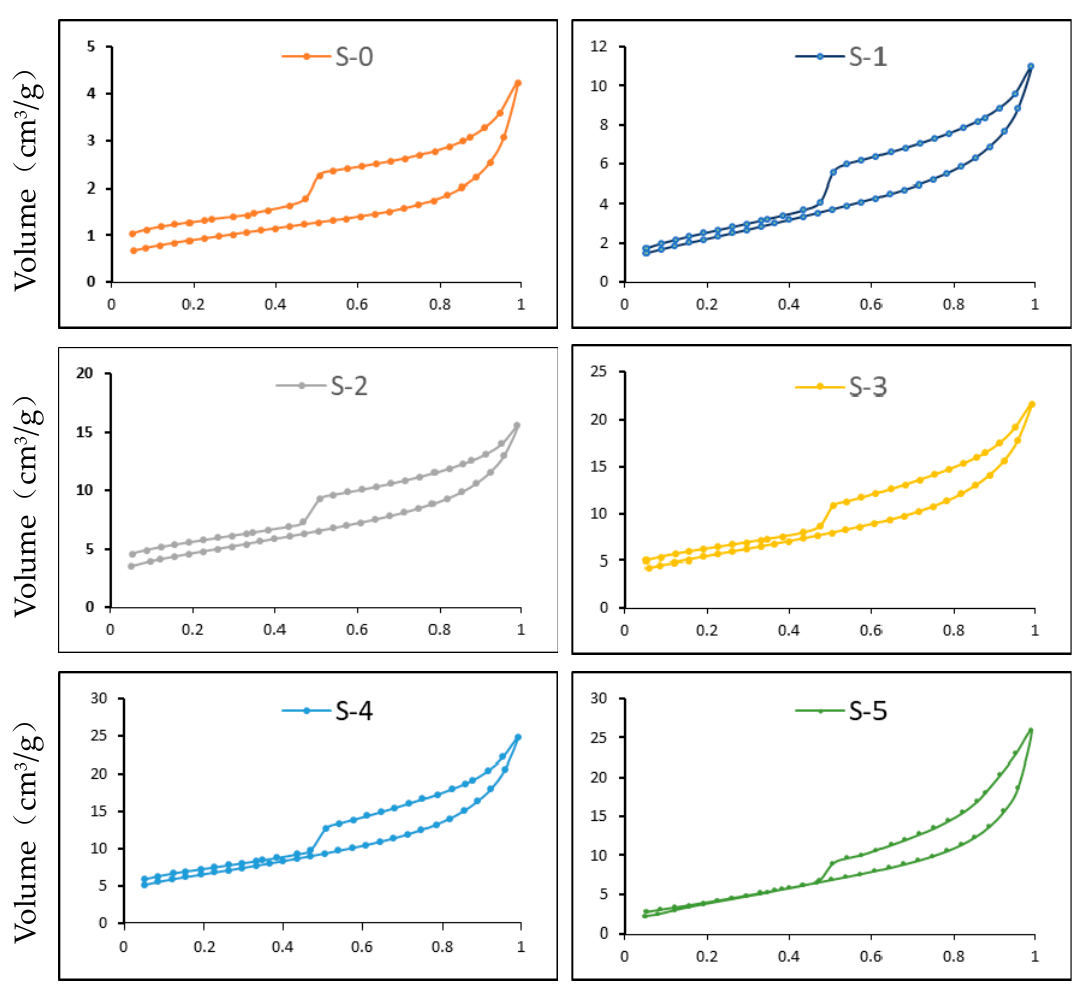
Figure 3. Adsorption-desorption isotherms of raw and treated shale particles.